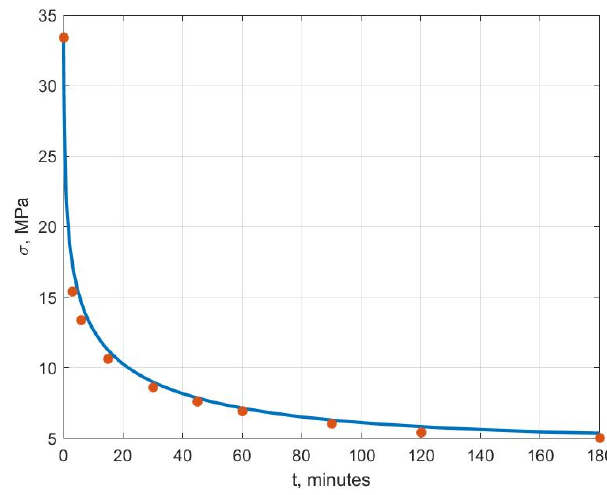
Figure 10. Stress relaxation curve at 𝑇 = 60 °C .